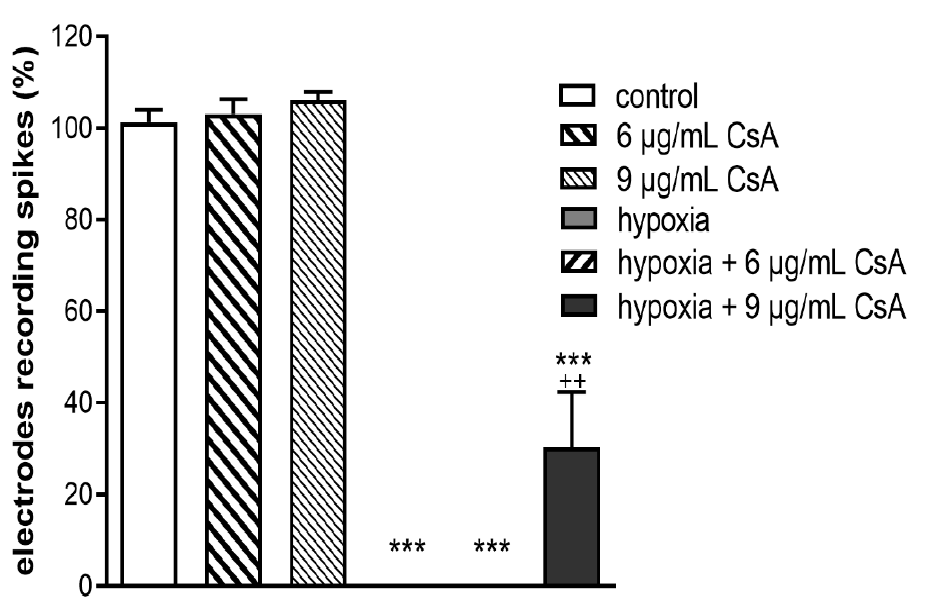
Figure 6. Spontaneous RGC activity. Bar graph represents the spontaneous RGC activity measured via multi-electrode assays (MEAs) with the control set to 100%. Hypoxia affected the spontaneous RGC activity, and this effect could not be reversed with treatment of 6 μ g/mL CsA. However, the loss of function after retinal hypoxia was counteracted up to 30% activity, but not reversed by 9 μ g/mL CsA ( p < 0.001). Bars and error bars indicate mean + SEM, n = 3–5 for all treatment groups. Significances are indicated as + with respect to the control condition and as * with respect to ischemic treatment using the following significance levels: + p < 0.01, *** p < 0.001.